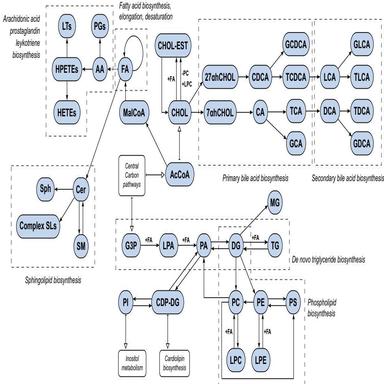
Metabolic network of the most affected pathways using transcriptomics-driven metabolic pathway analysis. We translated the statistically significant differentially expressed genes (Benjamini-Hochberg false discovery rate p −1.25) according to gene-proteinreaction rules. 27ahCHOL, 27a-hydroxycholesterol; AA, arachidonic acid; AcCoA, acetyl-coenzyme A; CA, cholic acid; CHOL, cholesterol; CDCA, chenodeoxycholic acid; CDP-DG, cytidine diphosphate diacylglycerol; Cer, ceramide; CHOL-EST, cholesterol ester; DCA,